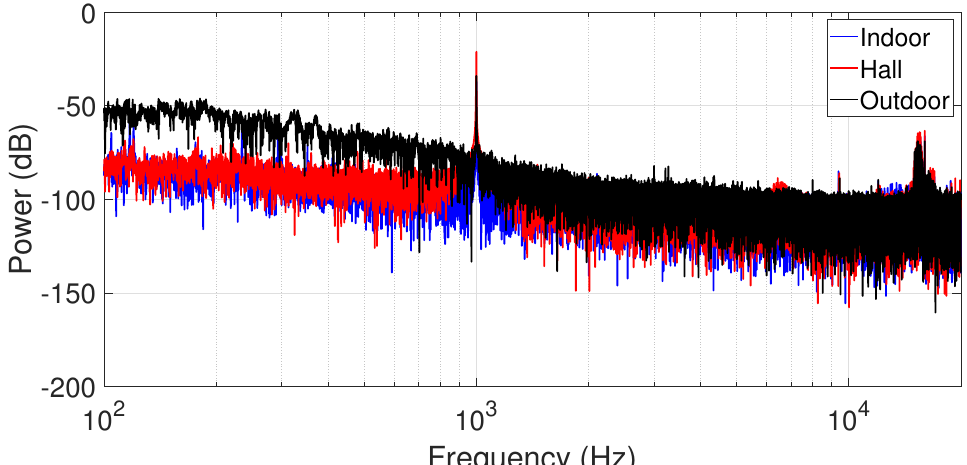
Figure 11. Power Spectrum Density of measured data in all scenarios (tone of 1 kHz of audio source).